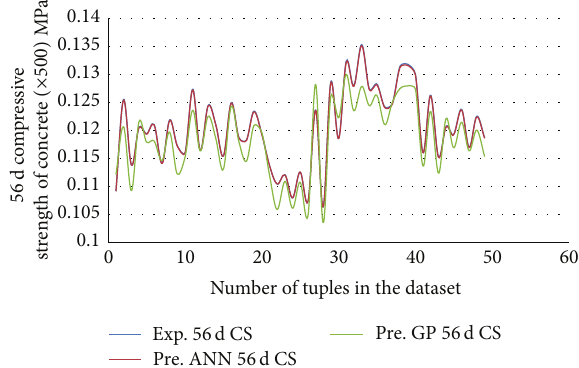
Figure 4: Comparison between actual and predicted values of 28 d compressive strength of concrete with FA.